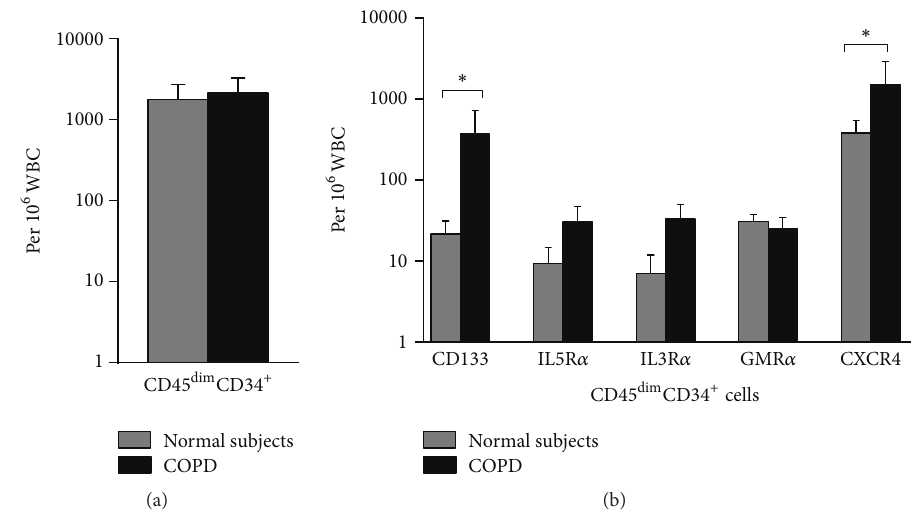
Figure 2: (a) Enumeration and (b) phenotyping by flow cytometry of sputum progenitor cells from COPD patients ( 𝑛 = 9 ) and normal nonatopic controls ( 𝑛 = 8 ). Data are presented as mean ± SEM; ∗ 𝑝 < 0.05 between group